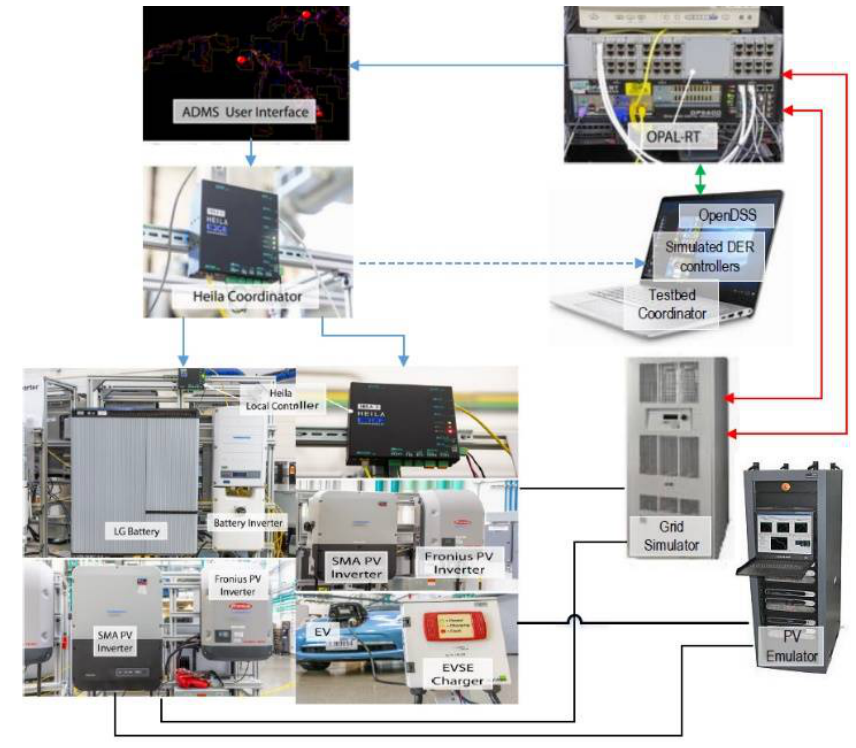
Figure 14. Components of the experimental setup of the HIL platform. Photos by NREL.